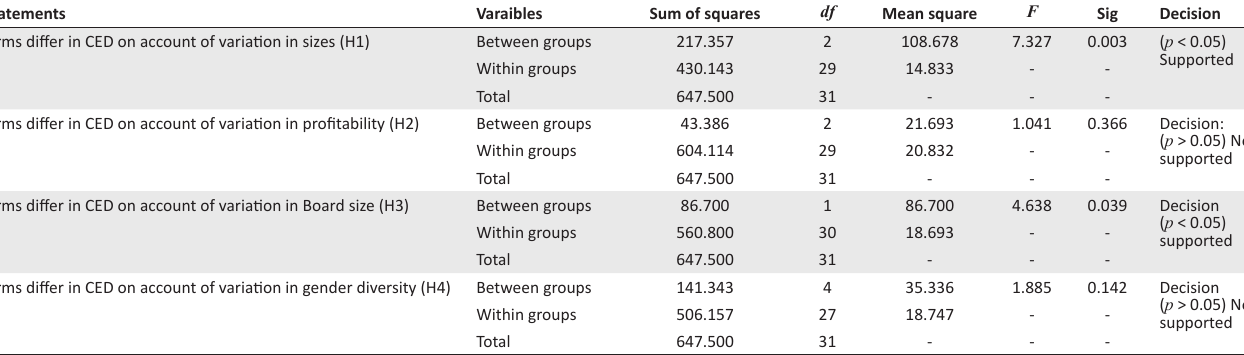
TABLE 5: ANOVA for corporate environmental disclosure index at different levels of firm